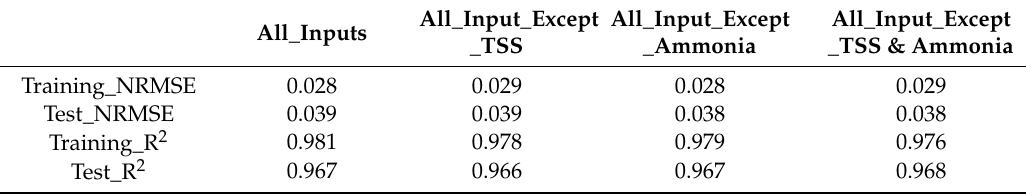
Table 2. Performance of the linear regression (LR) models based on the default influent file and di ff erent input vectors.